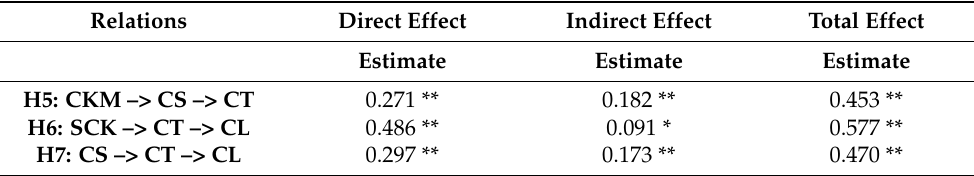
Table 8. Mediating results for the hypothesized